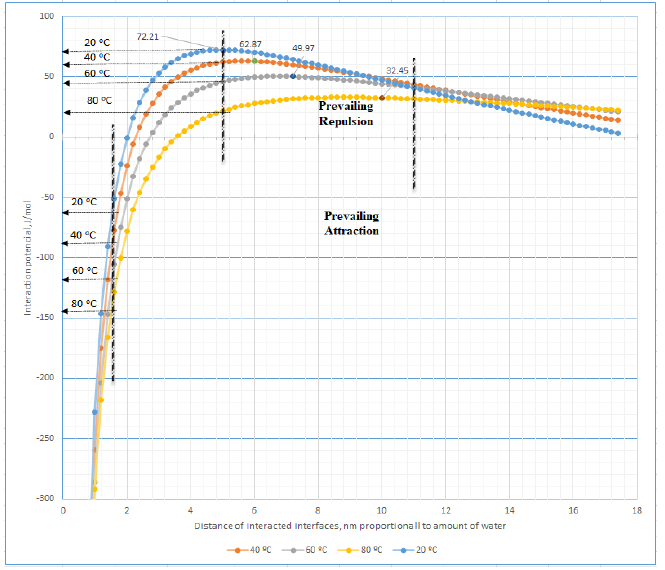
Figure A1. Dependence of the interaction potential isotherms vs. distance of mutually interacted micro-plates with mosaic organization of hydrated surfaces, i.e., vs. increased concentration of wa- ter in hydro-system.